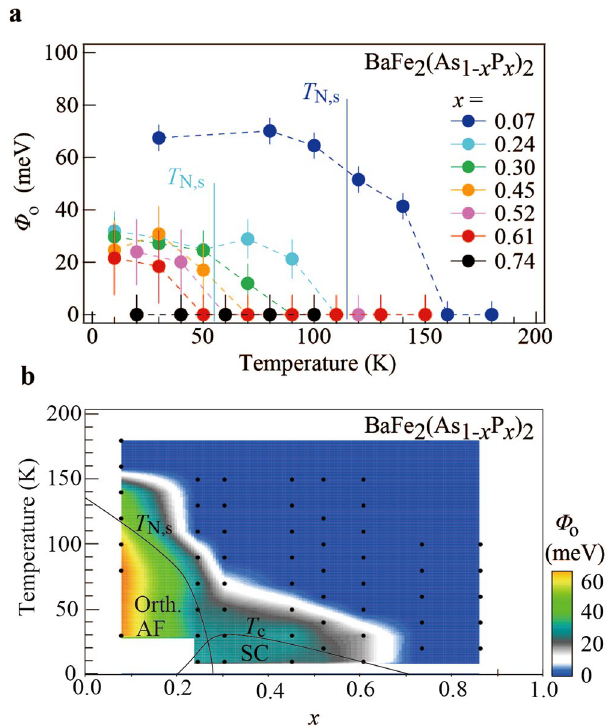
Figure 5. (a) Summary of x and T dependence of the orbital anisotropic parameter Φ o = E yz − E xz estimated from the second E derivative EDCs. (b) Contour plot of Φ o in the x - T phase diagram of AsP122 system. The measurement points were indicated by black